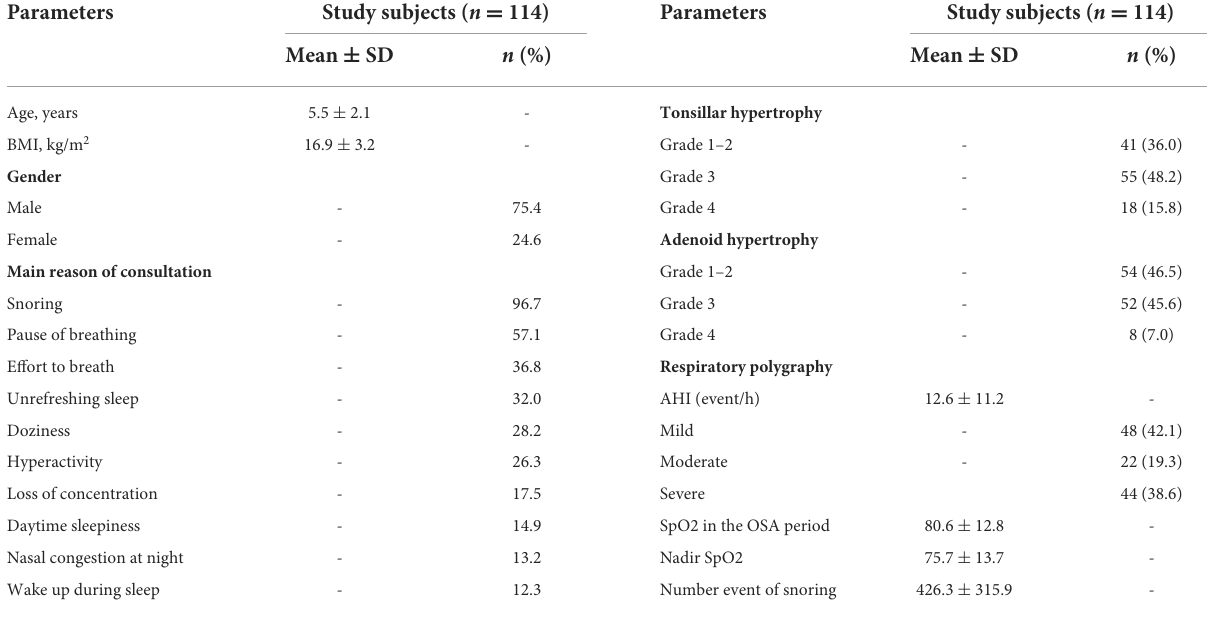
TABLE 1A Clinical characteristics and respiratory polygraphy features of study subjects.